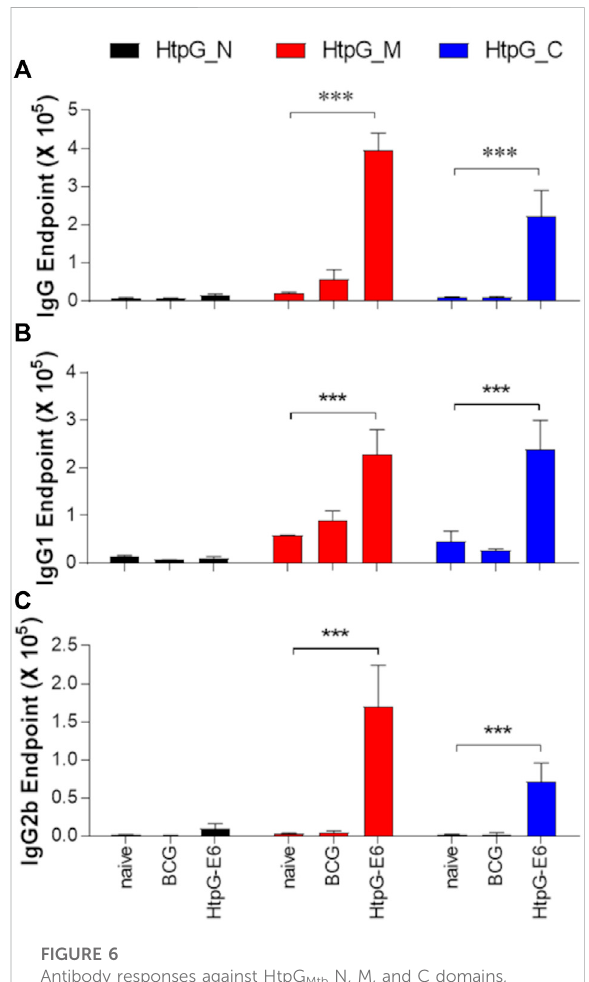
FIGURE 6 Antibody responses against HtpG Mtb N, M, and C domains, measured in the mice serum 6 weeks after the last immunisation or 10 weeks after BCG injection. Data are presented as mean ± SEM (n = 3); *** p <